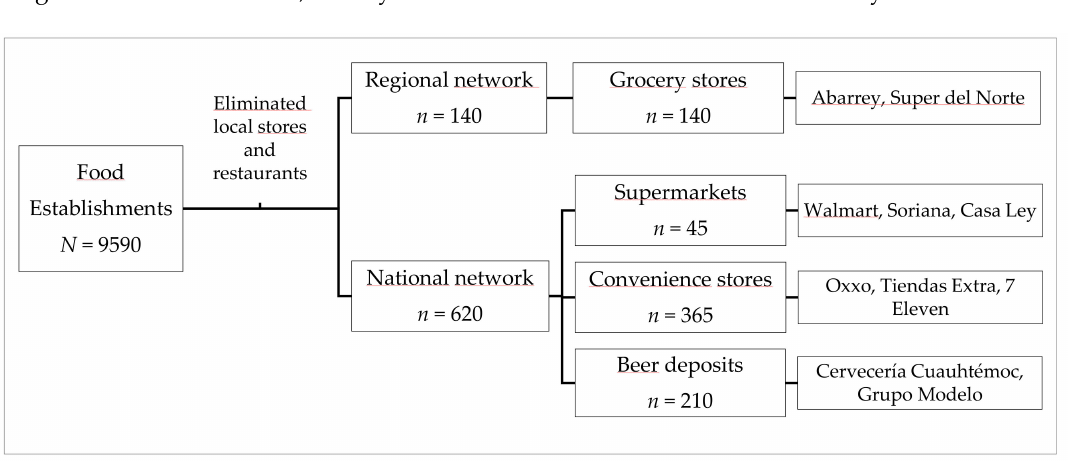
Figure 3. Categories of food establishments included for analysis ( n = 760). Source: Own elaboration (2018), data obtained from INEGI DENUE.